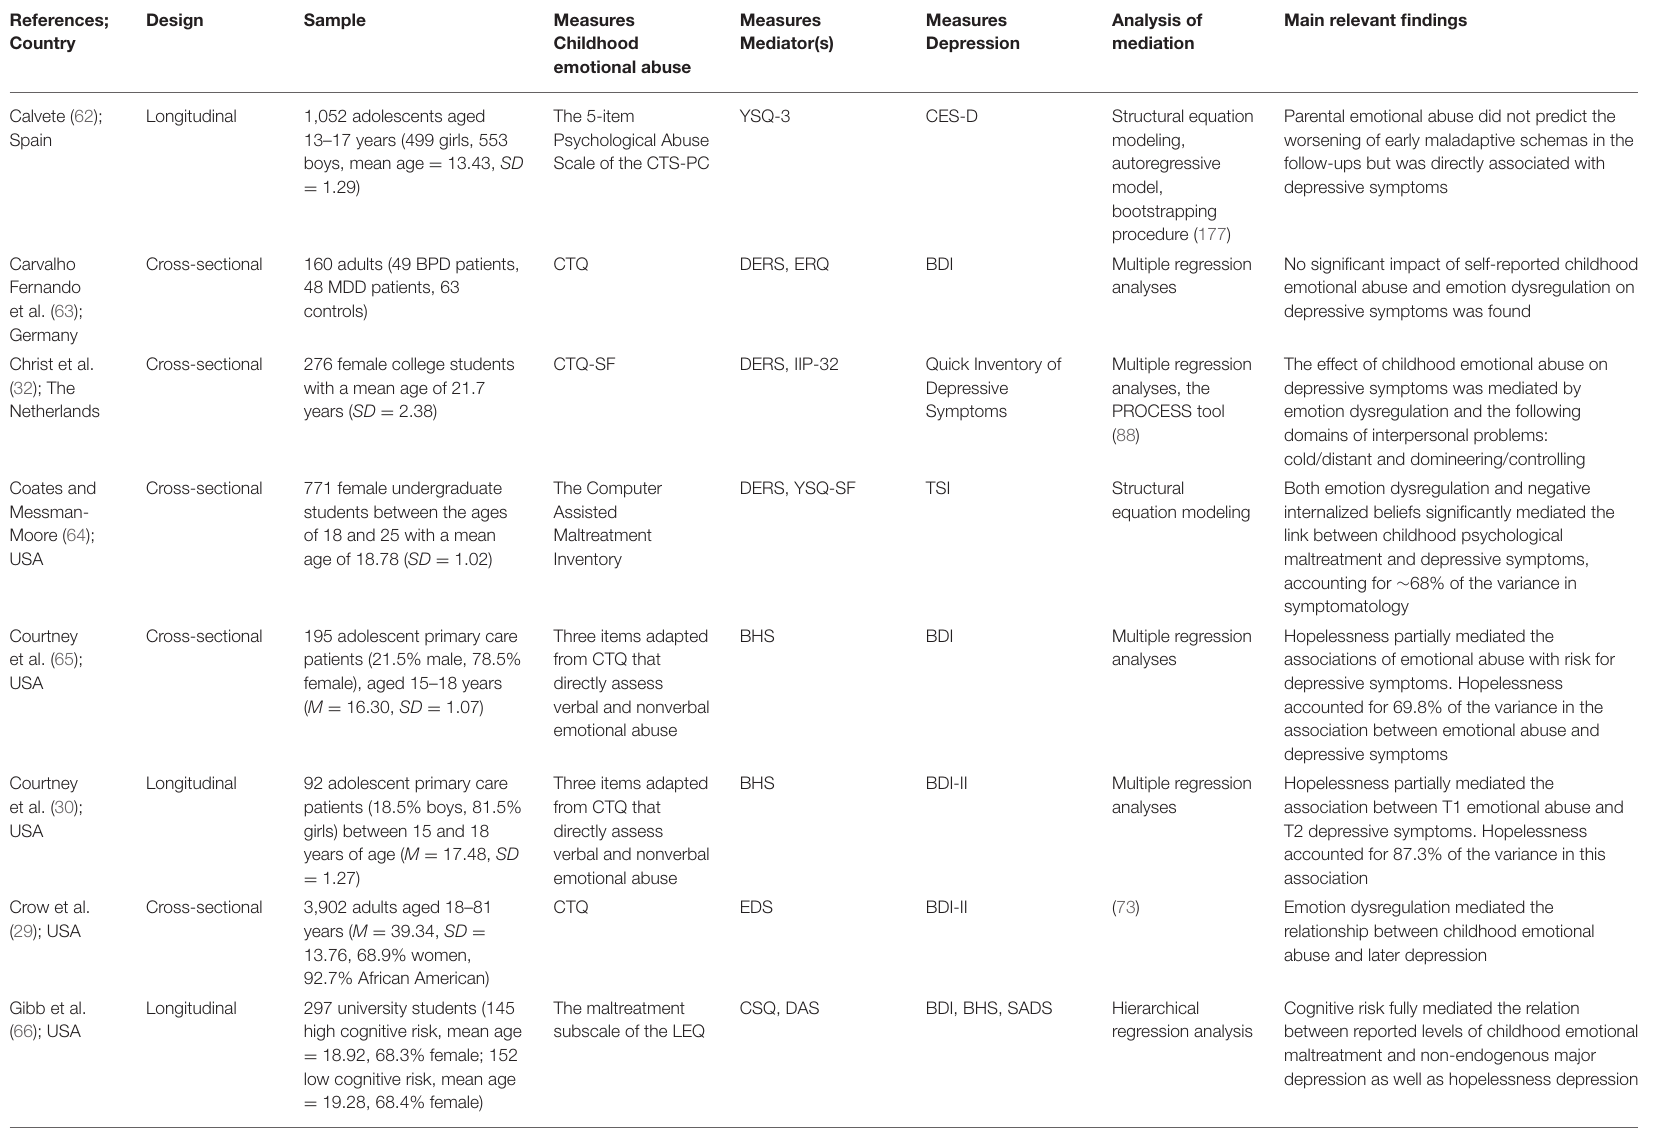
TABLE 1 | Overview of studies included in